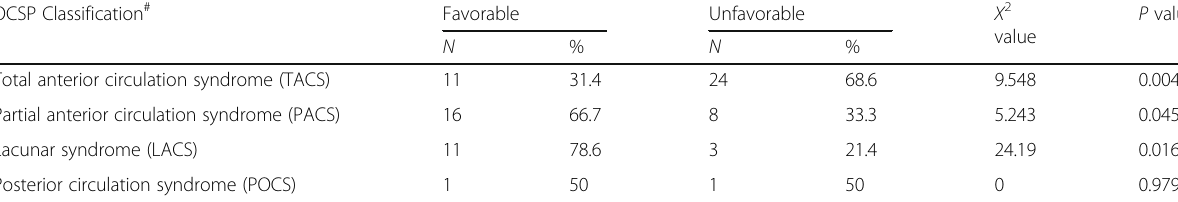
Table 4 Outcome of different subtypes of OCSP classification in group I OCSP Classification